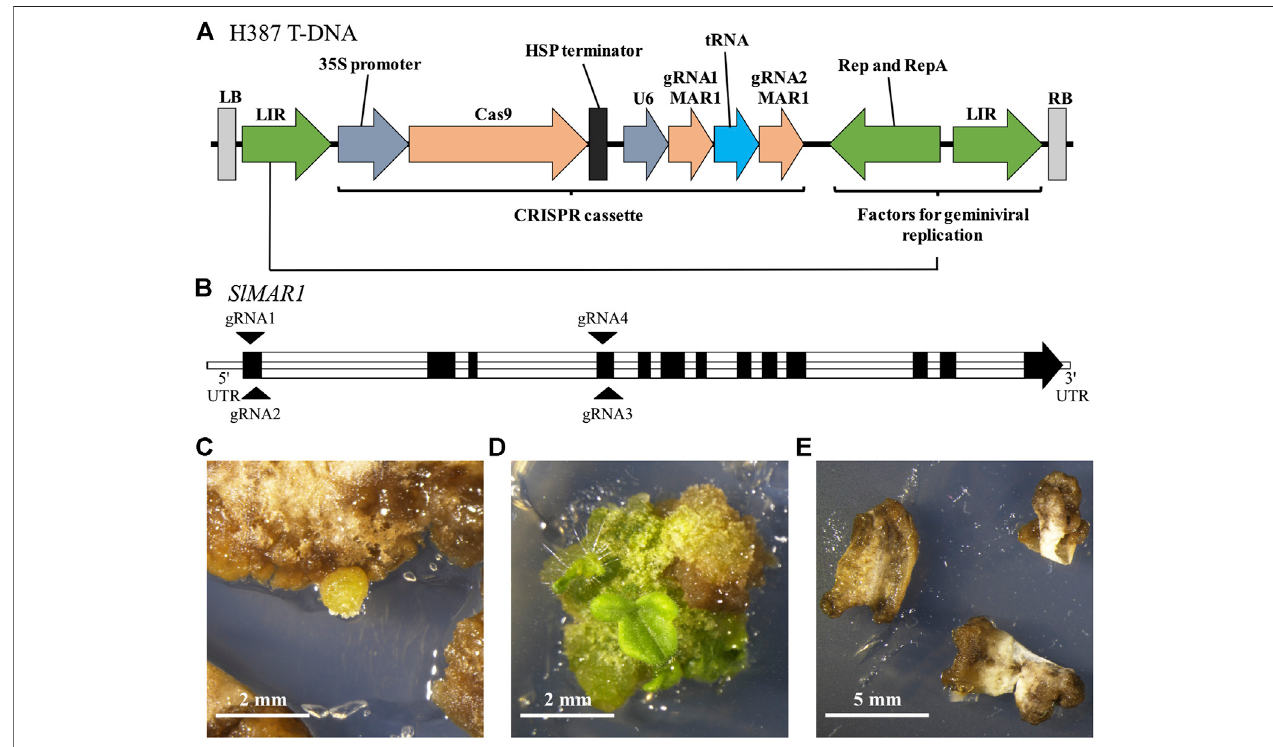
FIGURE 3 | Mutations inMAR1 oftomatoconfer kanamycinresistancetoleafexplantsintissue culture. (A) T-DNAofH387thatwas transferredintotomatoexplants. LIR:longintergenicregion,HSP:heatshockprotein18.2. (B) Intron-exonstructureofthelocusSolyc01g100610.3.1encoding Sl MAR1.TargetsitesforgRNAslocatedinthe fi rst and fourth exon are indicated with arrows. The gRNA1 and 2 were expressed by H387 and the gRNA3 and 4 were expressed by H386. (C) Leaf explants were transformed and placed on shoot-inducing medium containing 50 mg L − 1 kanamycin. Callus development occurred about 8 weeks after transformation. (D) Shoots developed 12 weeks after transformation. (E) Explants transformed with the control V118 showed no regeneration after 12 weeks.